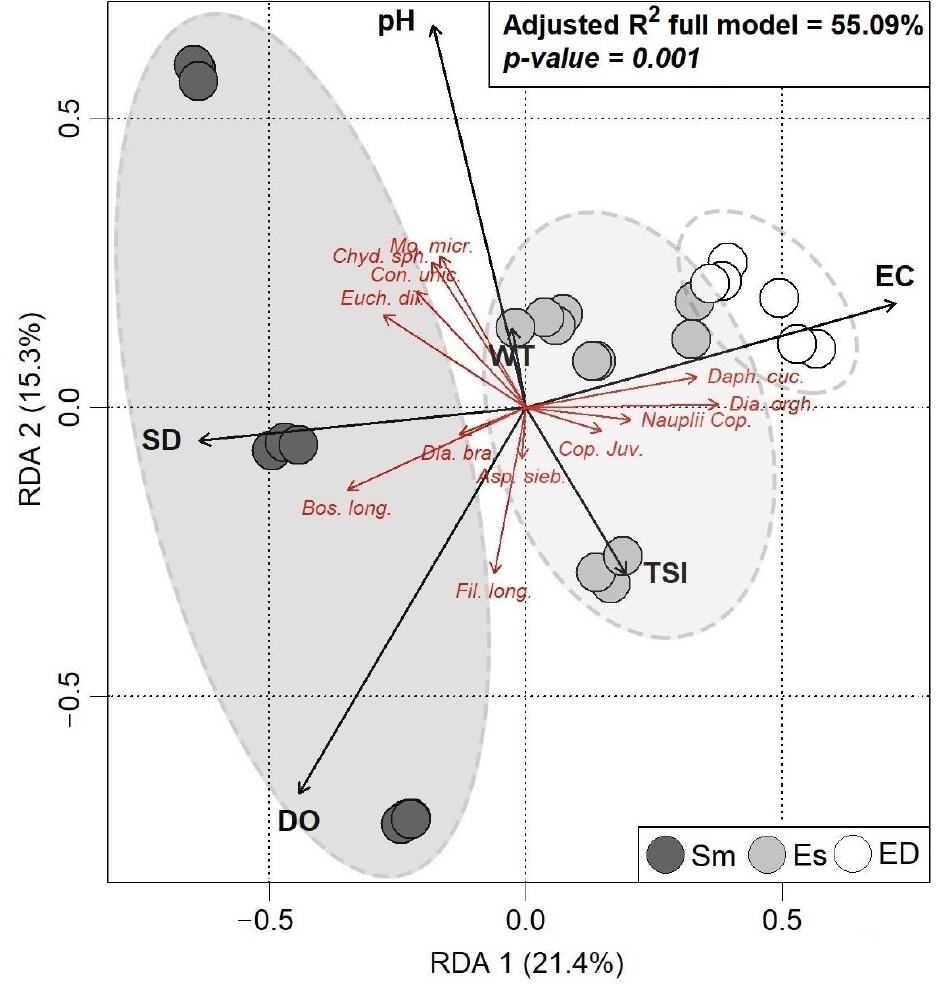
Figure 7. Redundancy analysis (RDA) plot for zooplankton community 2. ED—estuary–deltaic mouth areas; Es—estuarine mouth areas; Sm—simple mouth areas. Dominant species: Bos. long. — Bosmina longirostris ; Dia. bra. — Diaphanosoma brachyurum ; Nauplii Cop. — Nauplii Copepoda; Daph. cuc. — Daphnia cucullata ; Dia. orgh. — Diaphanosoma orghidani ; Cop. Juv. — Copepodit Juv.; Asp. sieb. — Asplanchna sieboldi ; Con. unic. — Conochilus unicornis ; Euch. dil. — Euchlanis dilatata ; Chyd. sph. — Chydorus sphaericus ; Mo. micr. — Moina micrura ; Fil. long. — Filinia longiseta